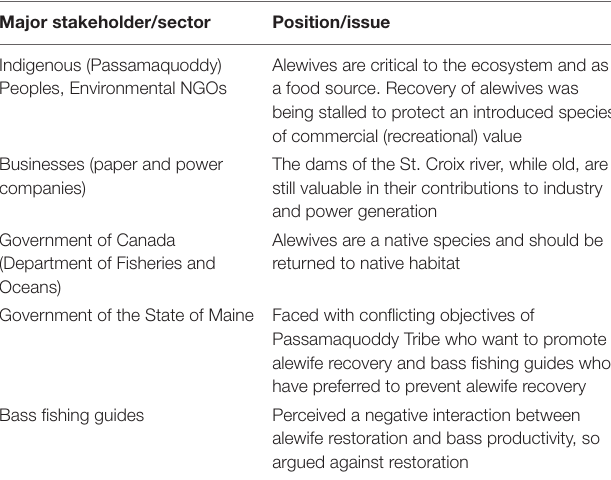
TABLE 2 | Views of major stakeholders regarding St. Croix River alewife recovery